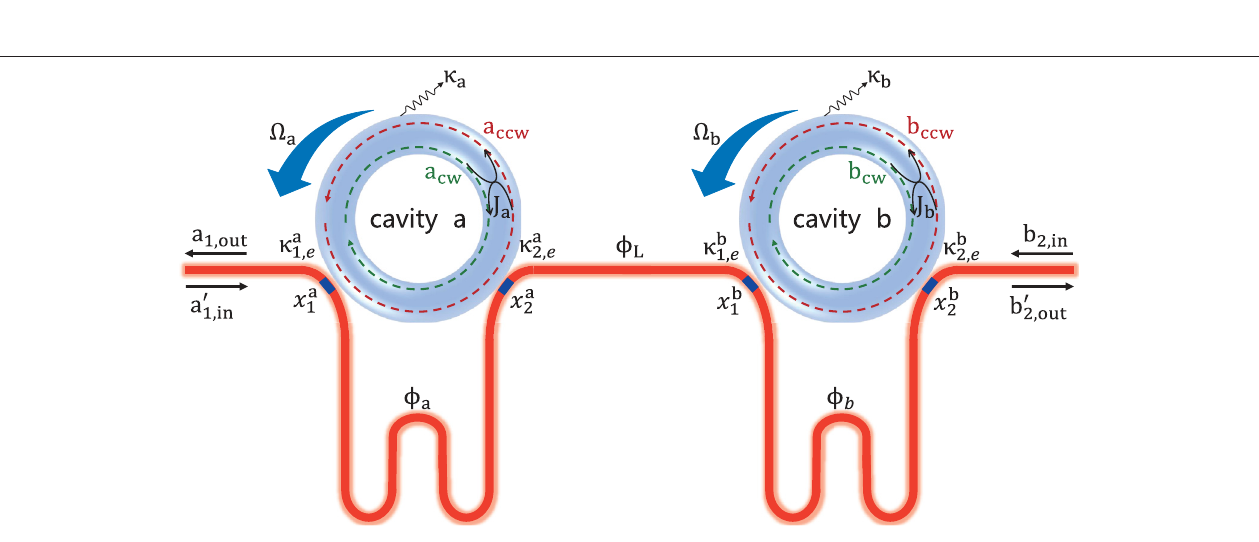
FIGURE4| (Coloronline)Schematicoftwoseparatespinningresonatorscoupledtoameanderingwaveguideatseveralcouplingpoints x a i and x b i with i =1,2.The resonator a ( b )withtheintrinsicdecayrate κ a ( κ b )rotates alongtheCCWdirectionat anangularspeed Ω a ( Ω b ).TheCWand CCWmodesoftheresonator a ( b )coupleto each other with strength J a ( J b ). The external loss rates at coupling points x a i and x b i are κ a i , e and κ b i , e , respectively. For the photon in the waveguide, the distance between neighboring coupling points results in different propagation phases denoting by ϕ a , ϕ L , and ϕ b . Note that { a 1 , in ′ , b 2 , in } and { b 2 , out ′ , a 1 , out } are the input and output operators of optical fi elds towards and away the